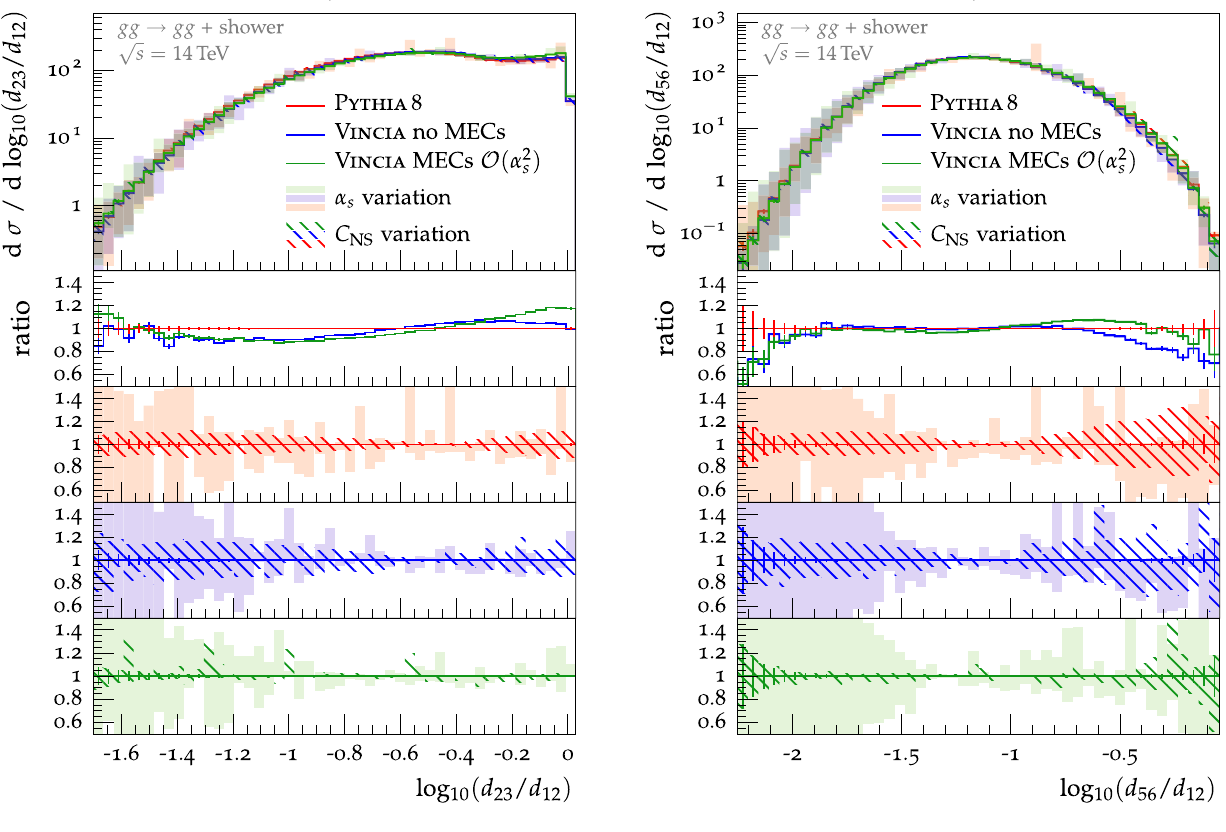
shown. The solid bands present a renormalisation-scale variation with k = 1 / 2 and2 andthehashedbandsavariationofthenonsingularterms with C NS = ±